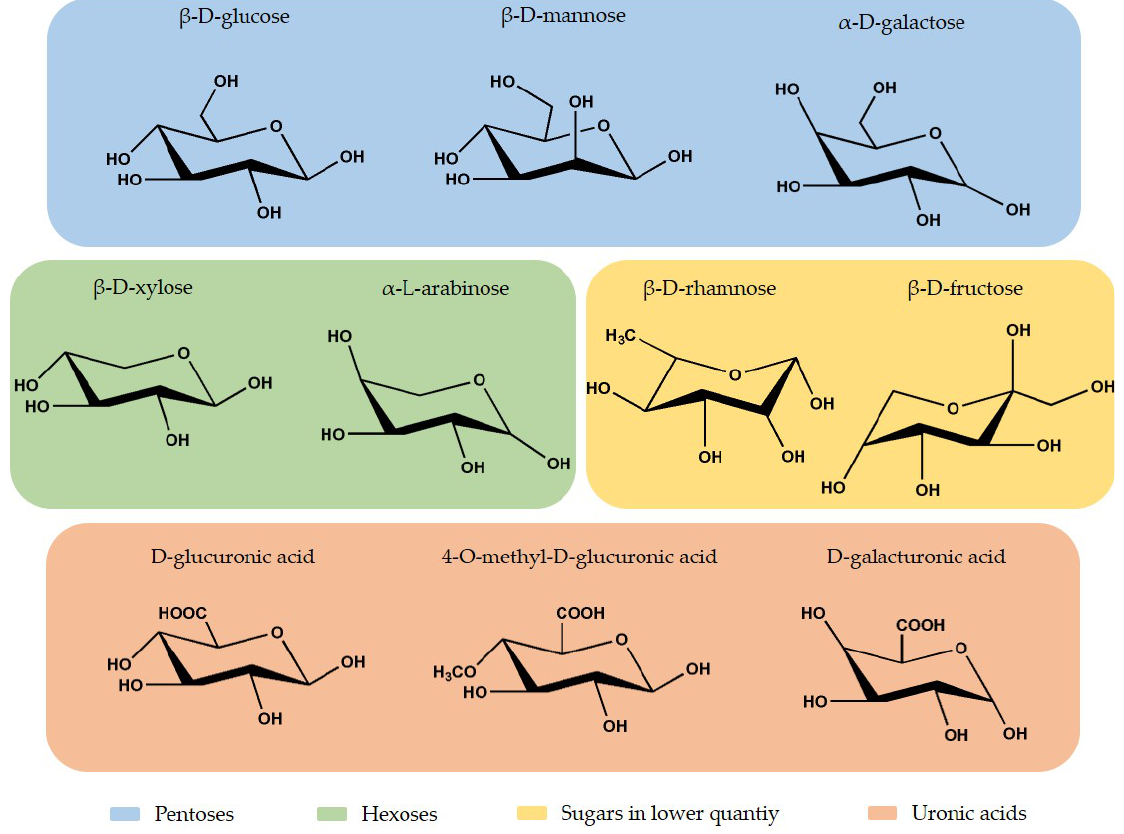
Figure 3. Chemical structure of hemicellulose monosaccharides units. Adapted from Wang [58], with permission. Copyrigth 2017, Elsevier.